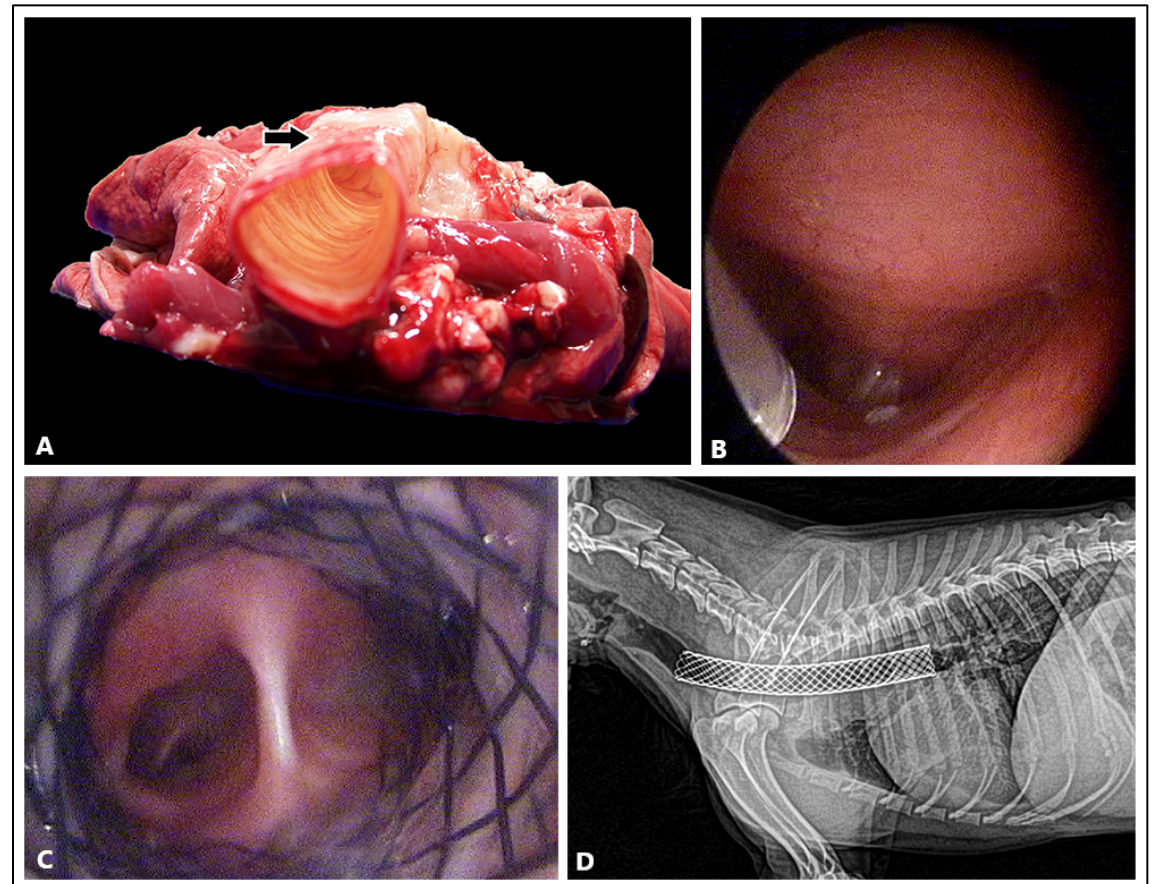
Figure 3. ( A ) Autopsy of a 15-year-old male dachshund euthanized due to end-stage cardio-respir- atory disorders related to chronic disease of the mitral valve and second degree tracheal collapse. The tracheal rings are deformed and the tracheal muscle closing the dorsal ring is overstretched and flaccid. The collapse of the muscle limited the lumen of the trachea on expiration and caused short- ness of breath. ( B ) Endoscopic examination of an 8-year-old male Yorkshire Terrier with third de- gree tracheal collapse. ( C ) Endoscopic examination after endotracheal stent implantation. ( D ) X-ray of the chest and neck in the lateral view after insertion of the stent. The photos were taken during the veterinary services of Dr Robert Paslawski.